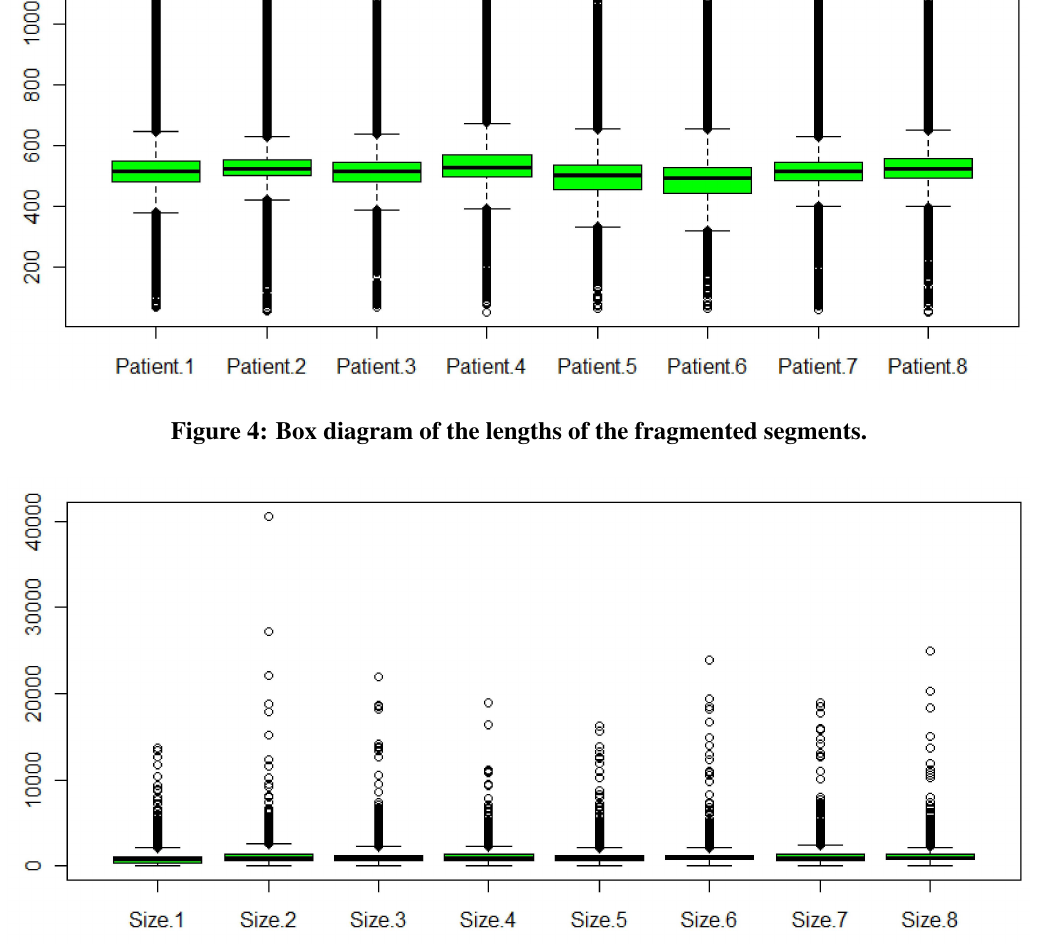
Figure 5: Box diagram with the length of the assembled contigs